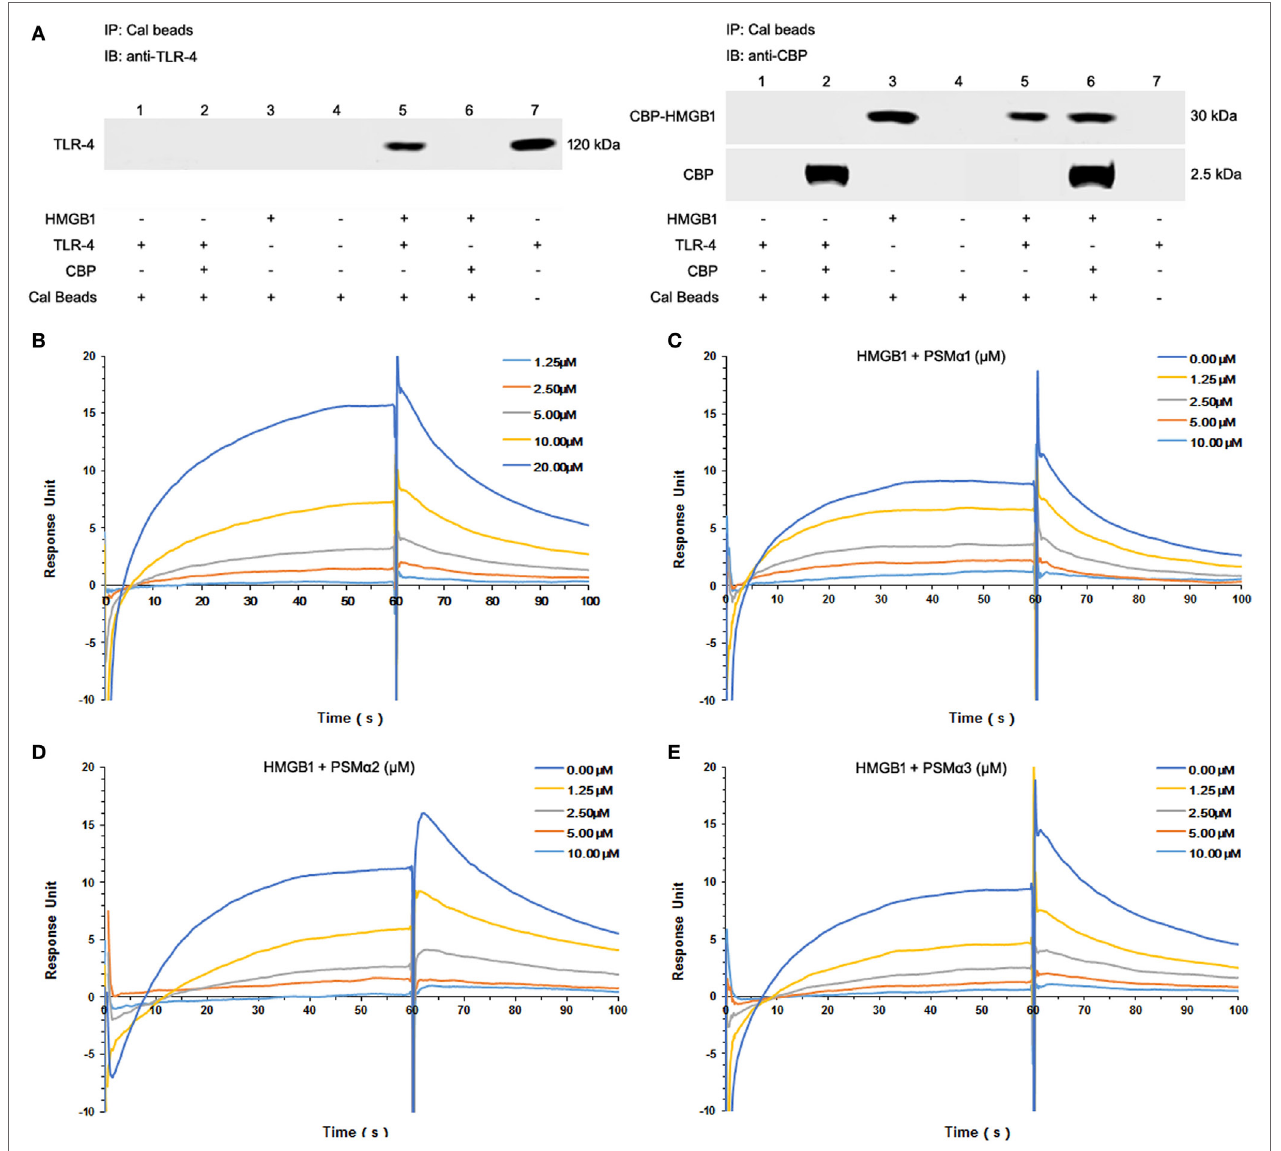
FigUre 2 | Staphylococcus aureus phenol-soluble modulins (PSMs) α 1– α 3 attenuate HMGB1-toll-like receptor (TLR4) binding. (a) Mixture of calmodulin-binding protein (CBP)-tagged HMGB1 or CBP alone with the HEK-Blue hTLR4 cell lysates was immunoprecipitated (IP) with calmodulin beads, and immunoblotted (IB) with anti-human TLR4 (hTLR4) or CBP antibodies. Recombinant hTLR4 protein was included as positive control (right lane 7). (B) Surface plasmon resonance (SPR) analysis was performed to assess HMGB1 binding to hTLR4. HMGB1 binding to hTLR4 was tested at different concentrations (1.25, 2.5, 5.0, 10.0, and 20 µM) with a K D value of 9.199 µM. SPR analysis of HMGB1 binding to TLR4 was performed in the presence of PSM α 1 (c) , PSM α 2 (D) , PSM α 3 (e) as shown. Data were representative of three